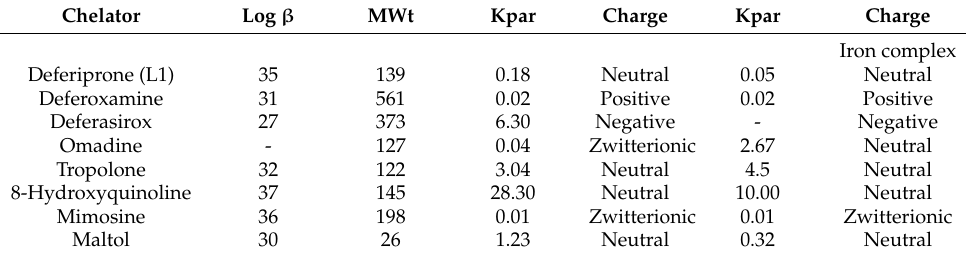
Figure 3. The structure of naturally occurring plant products (phytochelators) with iron-binding and anticancer properties. Mimosine ( 1 ), maltol ( 2 ), ascorbic acid (vitamin C) ( 3 ), isopropyl tropolone ( 4 ), tropolone ( 5 ), 8-hydroxyquinoline ( 6 ), 1-hydroxypyridine-2-thione or omadine ( 7 ). Table 1. Physicochemical properties of chelators and their iron